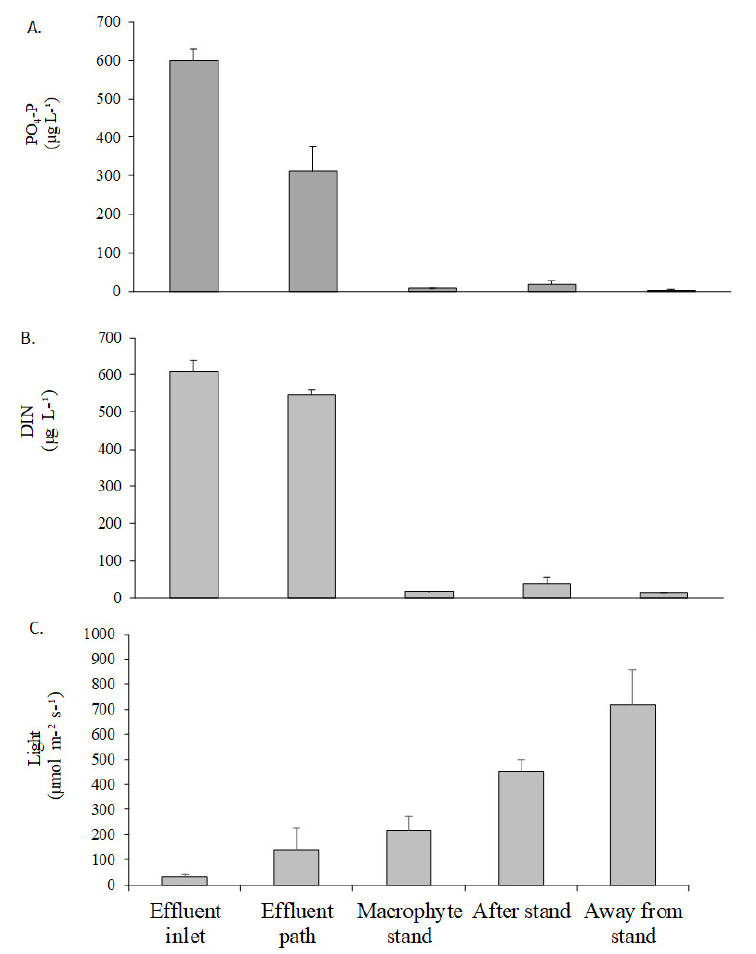
Figure 2. Dissolved nutrient concentrations and light availability (mean; SD; n = 3) in the sampling sites.